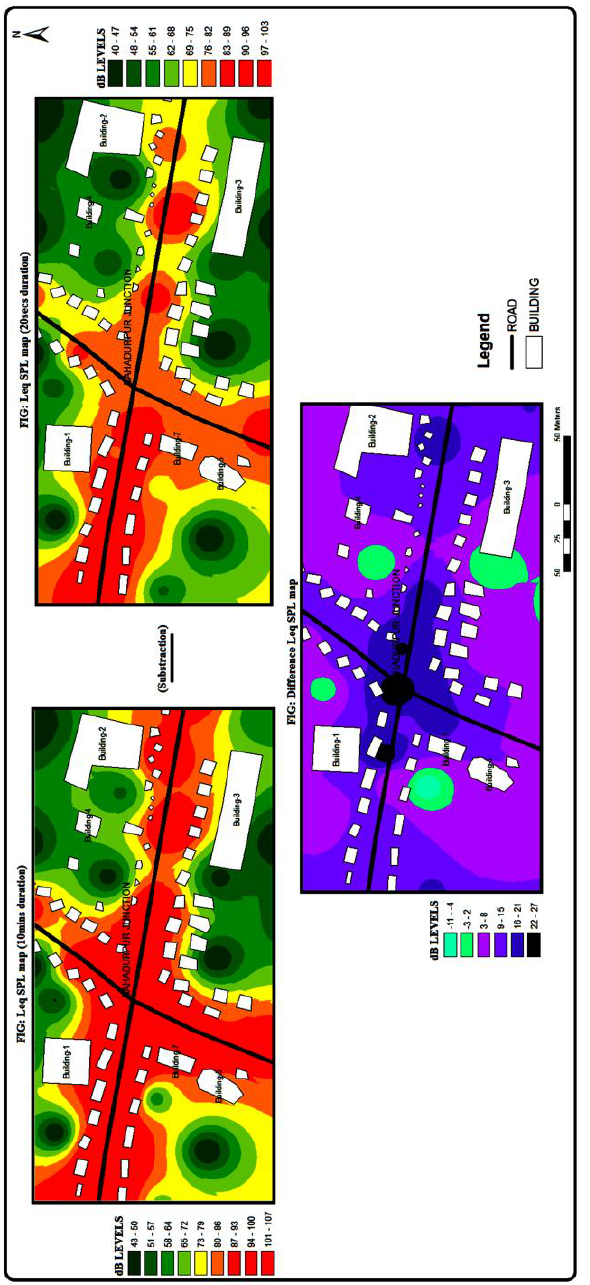
Figure 9. Average Noise Maps in Bahadurpur Crossing for Instantaneous and Short Time Duration and their Difference at 9-10